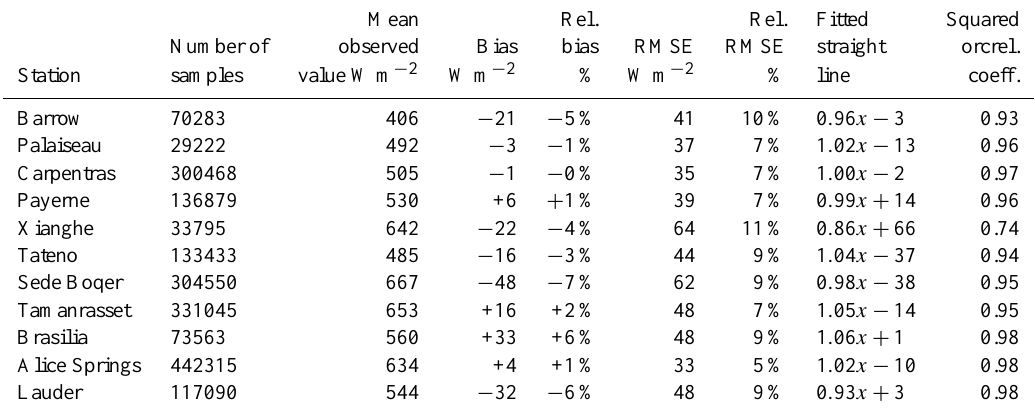
Table 3. Comparison between clear-sky beam irradiances on horizontal surface measured by BSRN and estimated by McClear. Mean Rel. Rel. Fitted Squared Number of observed Bias bias RMSE RMSE straight orcrel.